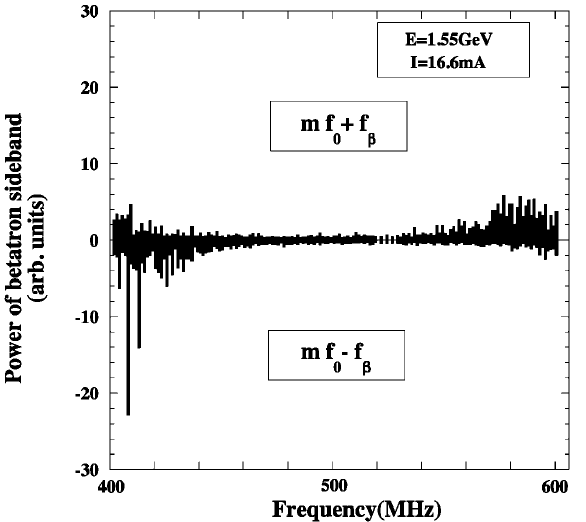
FIG. 2. Vertical betatron sidebands at a beam energy of 2.0 GeV. The positive and negative values correspond to mf (cid:11) f f and mf , (cid:21) (cid:21) 0